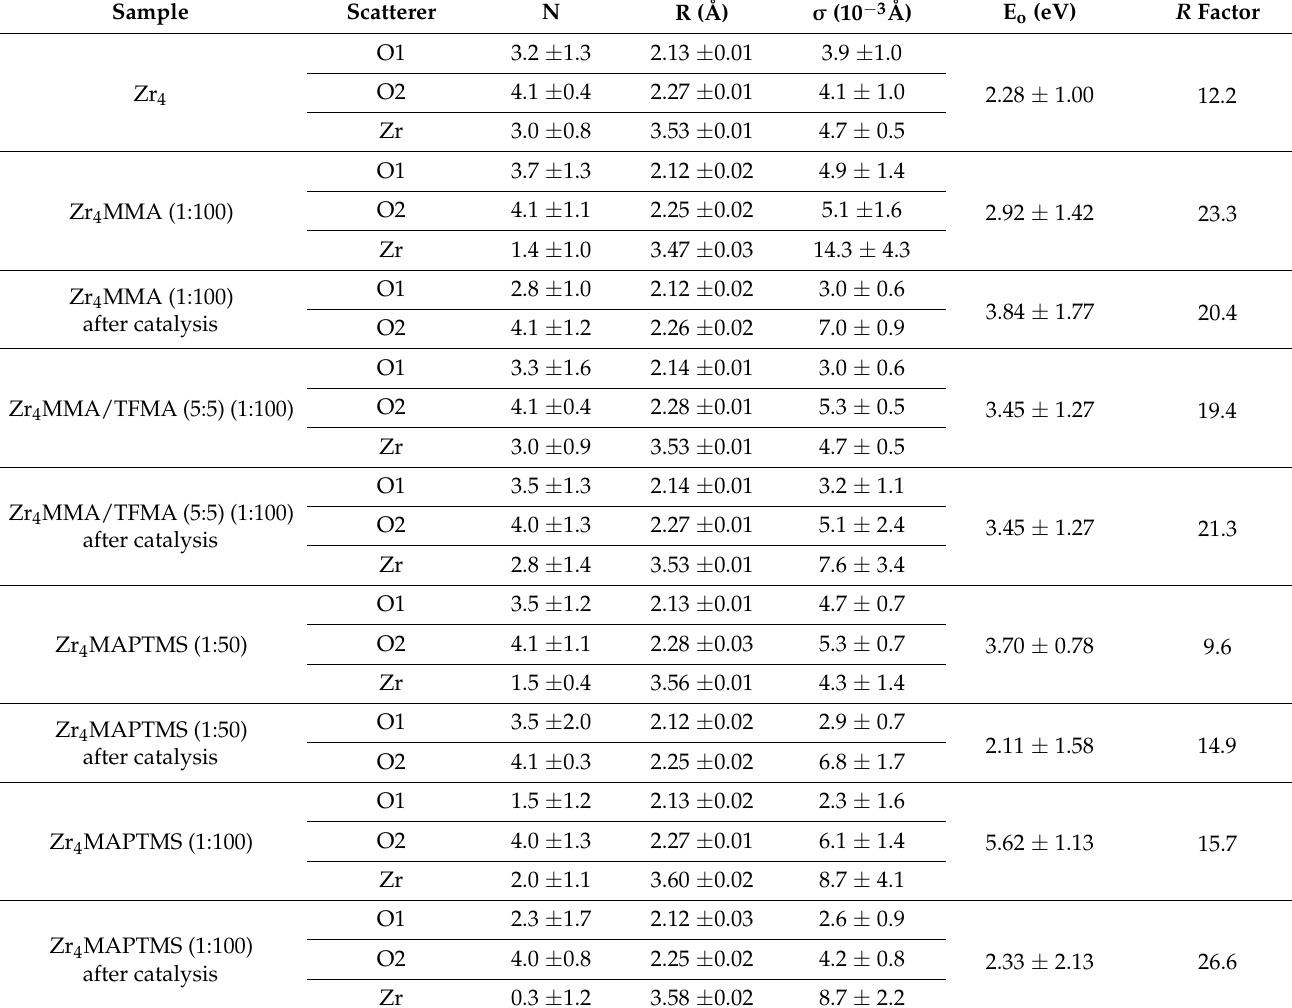
Table 6. Numeric results from fitting the experimental EXAFS spectra with theoretical